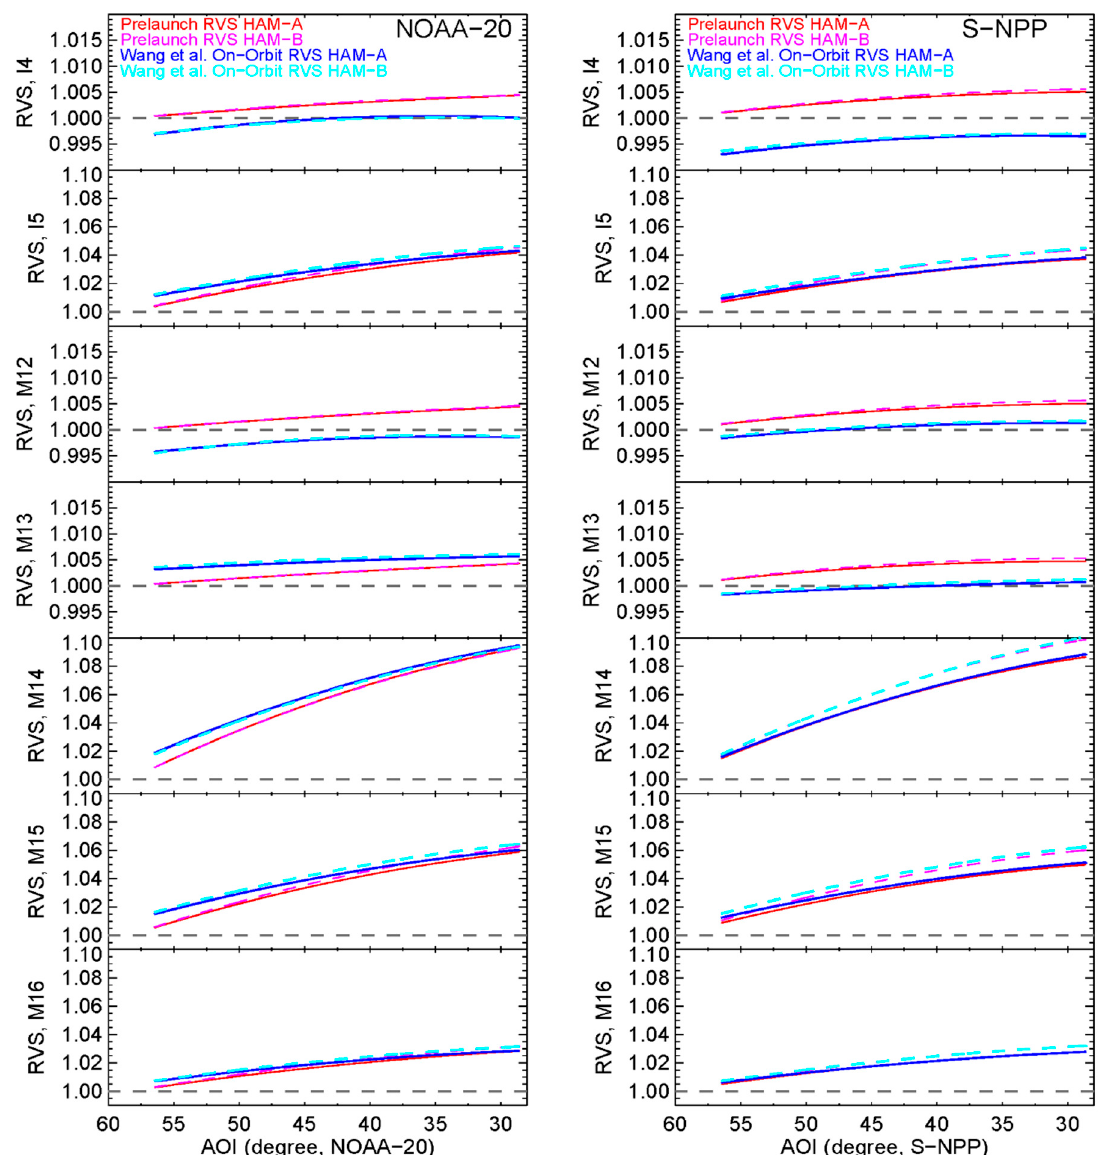
Figure 8. Comparison of band-averaged NOAA-20 (left panel) and S-NPP (right panel) prelaunch and the Wang et al. method derived on-orbit RVS for HAM-A (solid lines) and HAM-B (dash